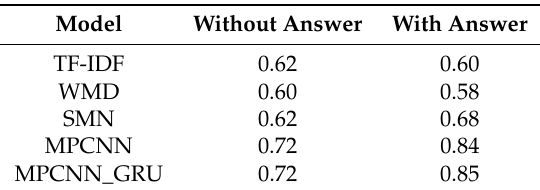
Table 6. Semantic matching results for user question.